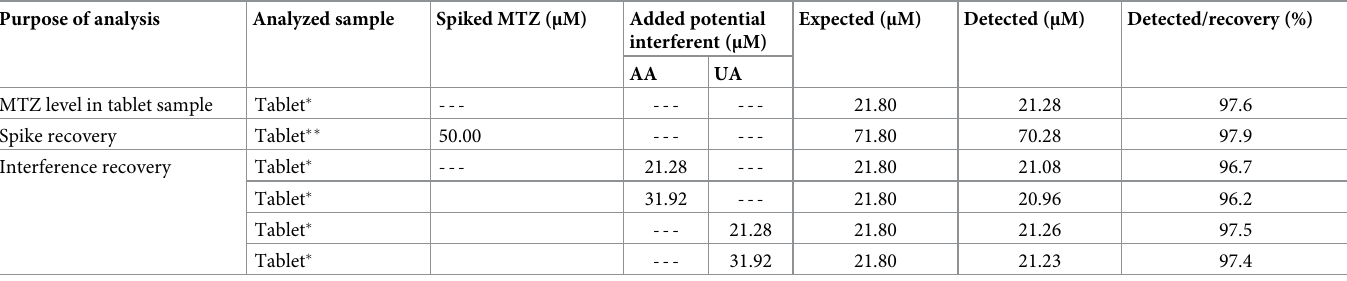
Table 2. Summary results of level of MTZ in tablet sample, spike recovery, and interference recovery at 100 and 150% of selected potential interferents. Purpose of analysis